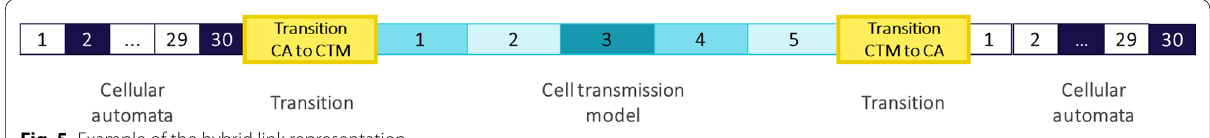
Fig. 5 Example of the hybrid link representation